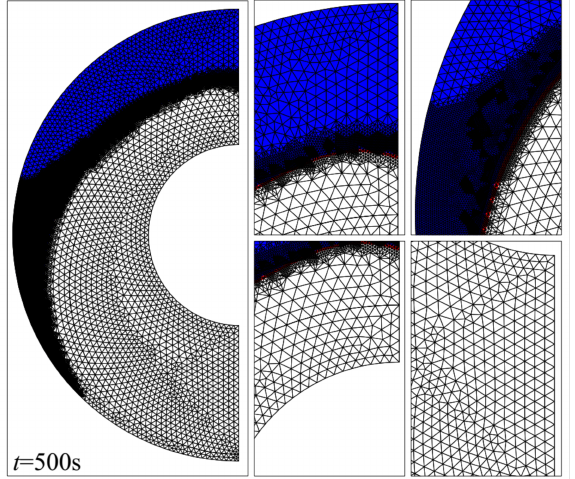
Figure 4. Mesh adaptation at t = 500 s. The white regions represent regions where the phase change material has melted, and the blue regions correspond to the solid zone. The apparent black region is a result of the mesh being too fine to resolve at this scale, such that only the element boundaries are